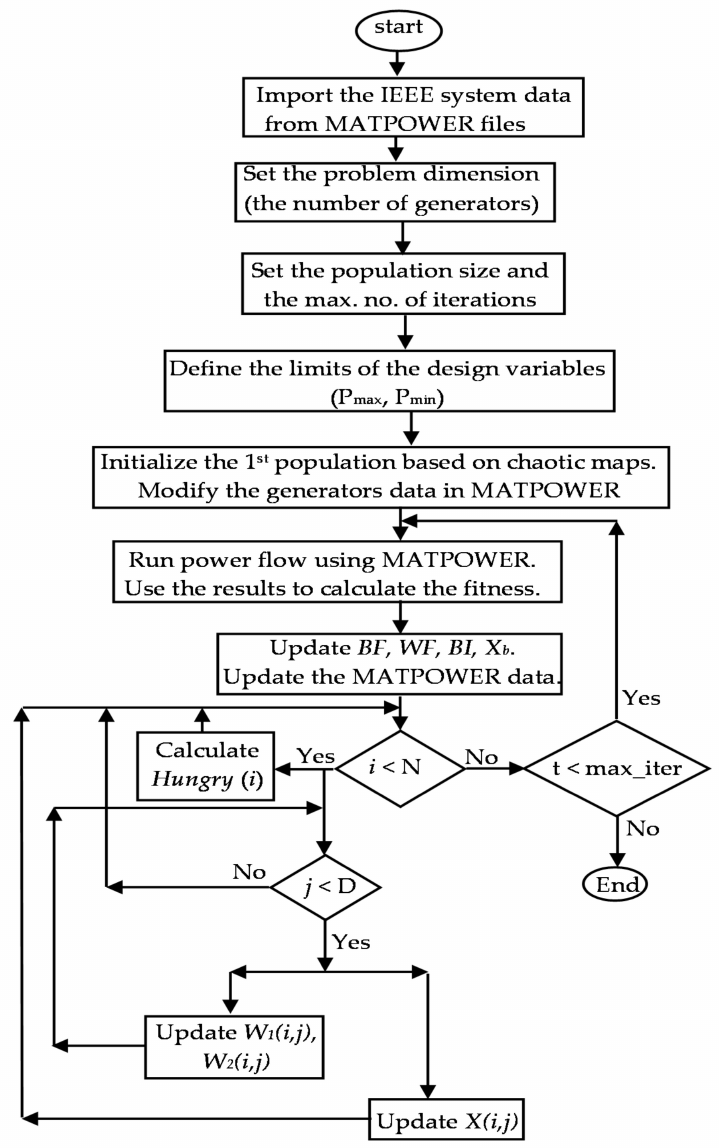
Figure 2. Flowchart of the power flow using the CHGS optimization